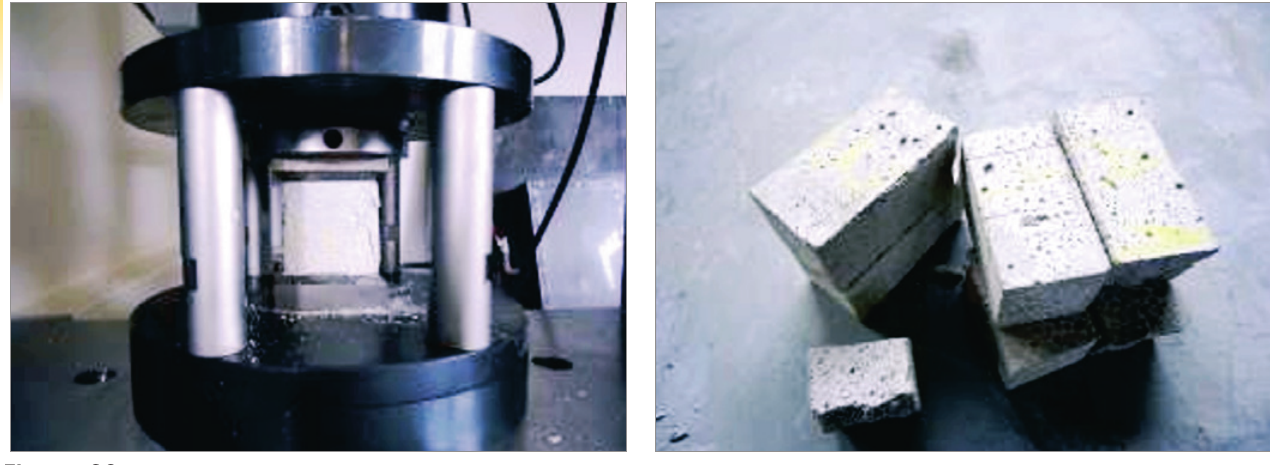
Ilustração dos ensaios das argamassas utilizadas Tabela 9 Resistências à compressão média das argamassas